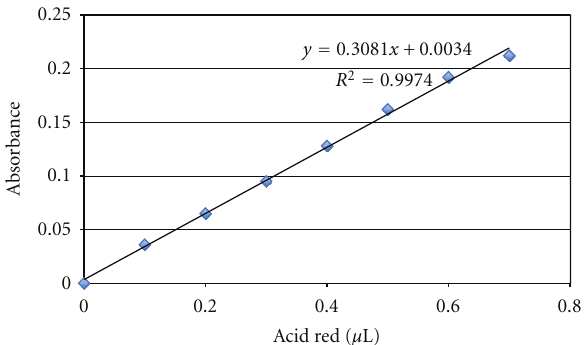
Figure 2: The absorbance curve was used to quantify the amount of the color marker release through the connection between implant- abutment.